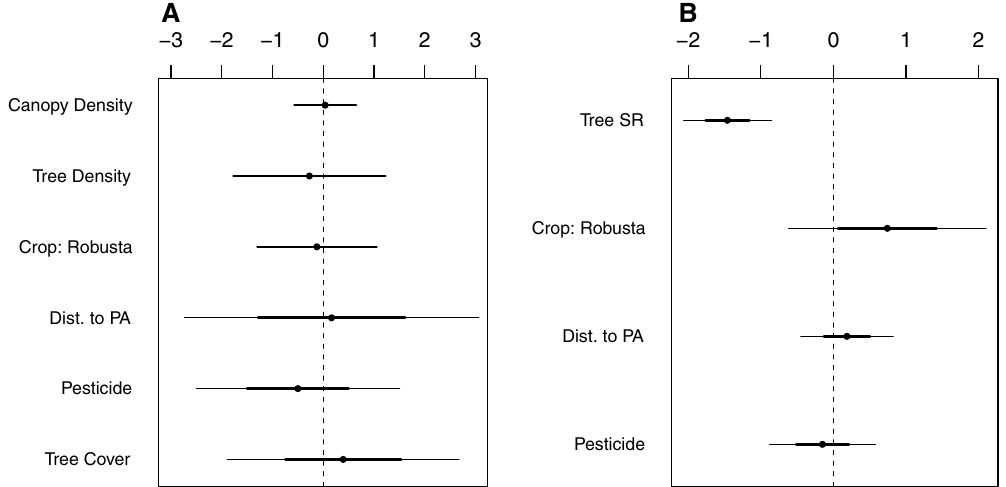
Figure 4. Model-averaged regression coefficients predicting ( A ) forest-dependent and ( B ) endemic species richness in arabica and robusta . The variable names are shown in column on the left. “Tree SR” represents tree species richness; “Dist. to PA” distance to protected